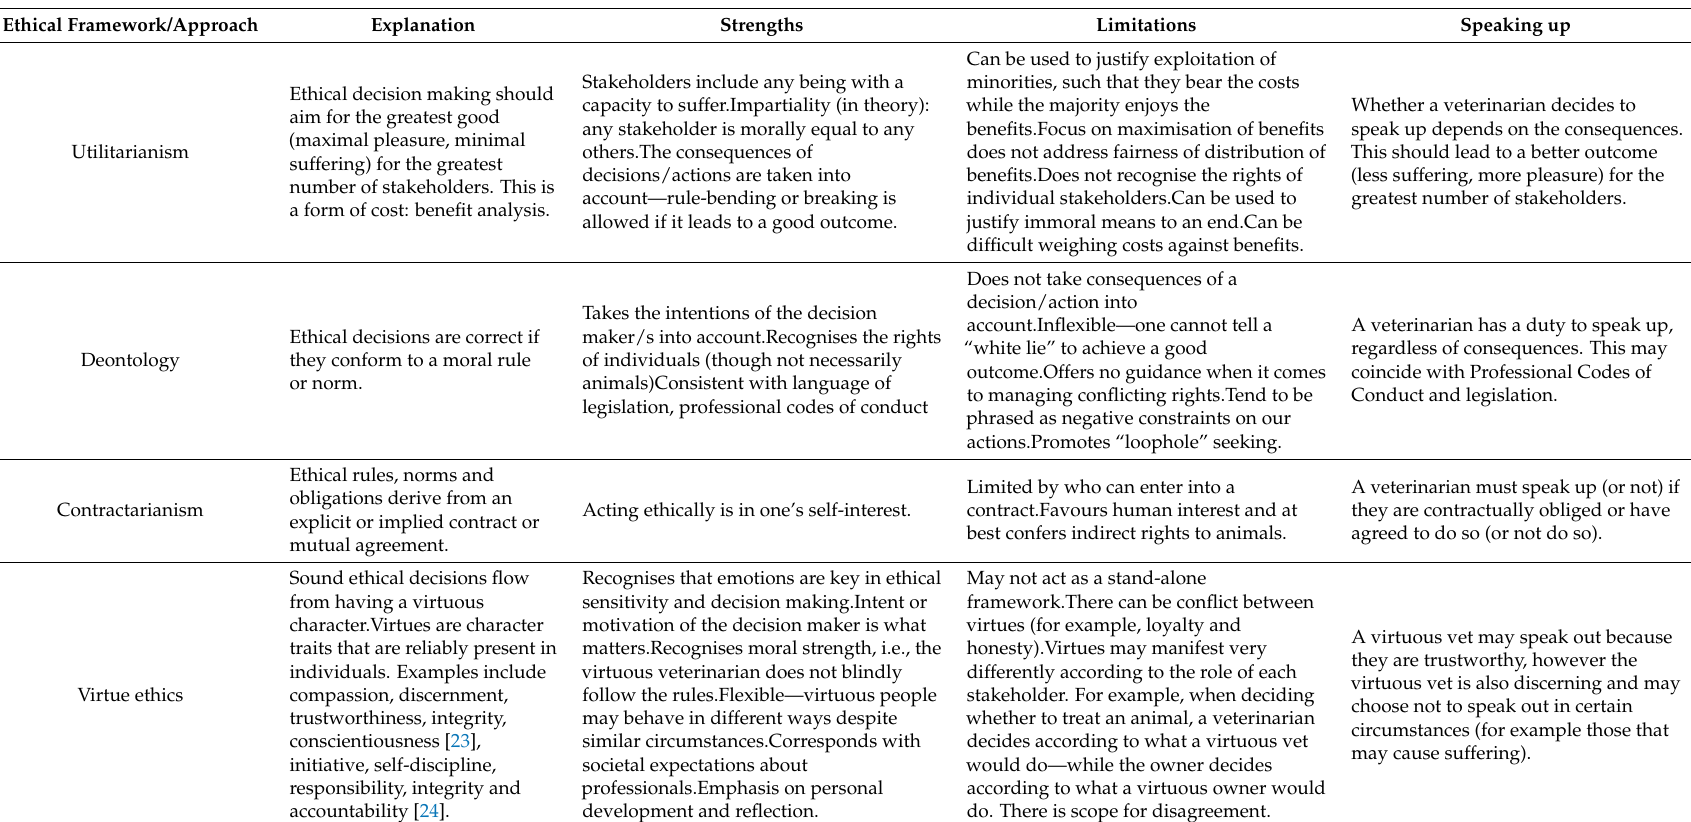
Table 1. Strengths and limitations of key ethical frameworks and approaches taught to veterinary students and an interpretation of how “speaking up” may be conceived according to each framework or approach. Adapted from Mullan and Fawcett